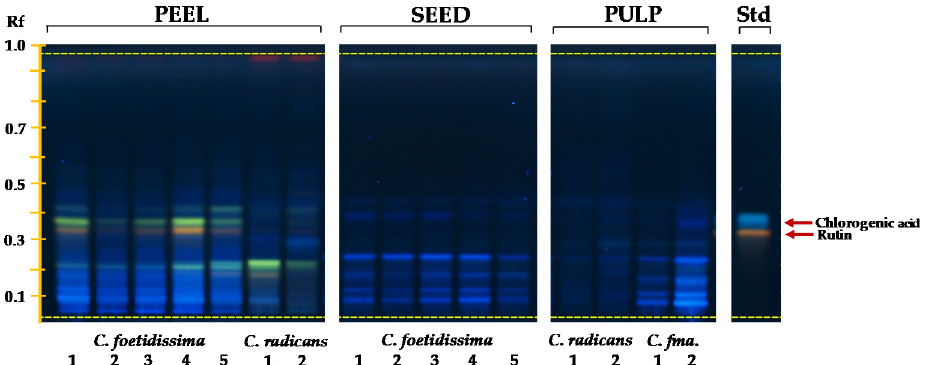
under UV light (366 nm) after derivatization with the Natural Products reagent. The red arrows in- dicate bands whose Rf values corresponded to those of reported standards (Std): Rutin and chloro- genic acid. C. fma. = Cucurbita foetidissima .